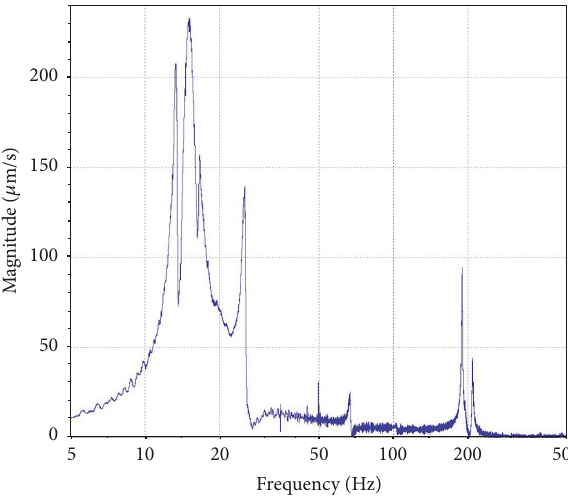
Figure 10: Frequency response characteristic of the energy har- vester.